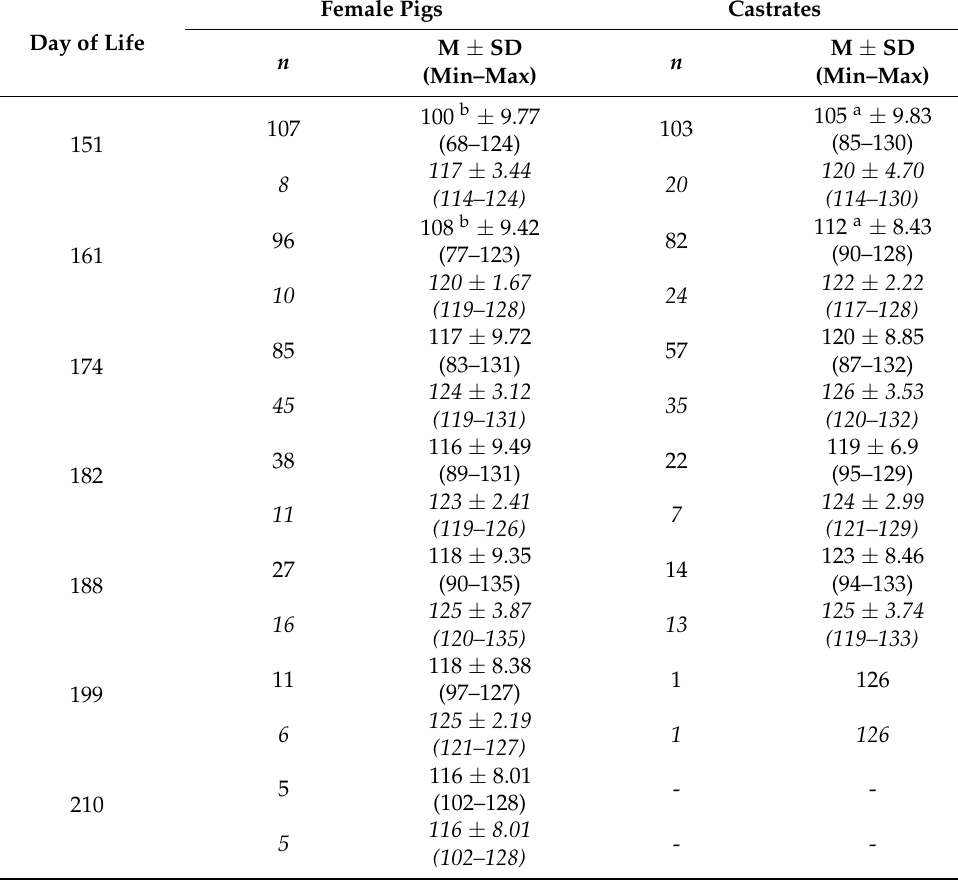
Table 5. Live weight of pigs (kg) at the time of